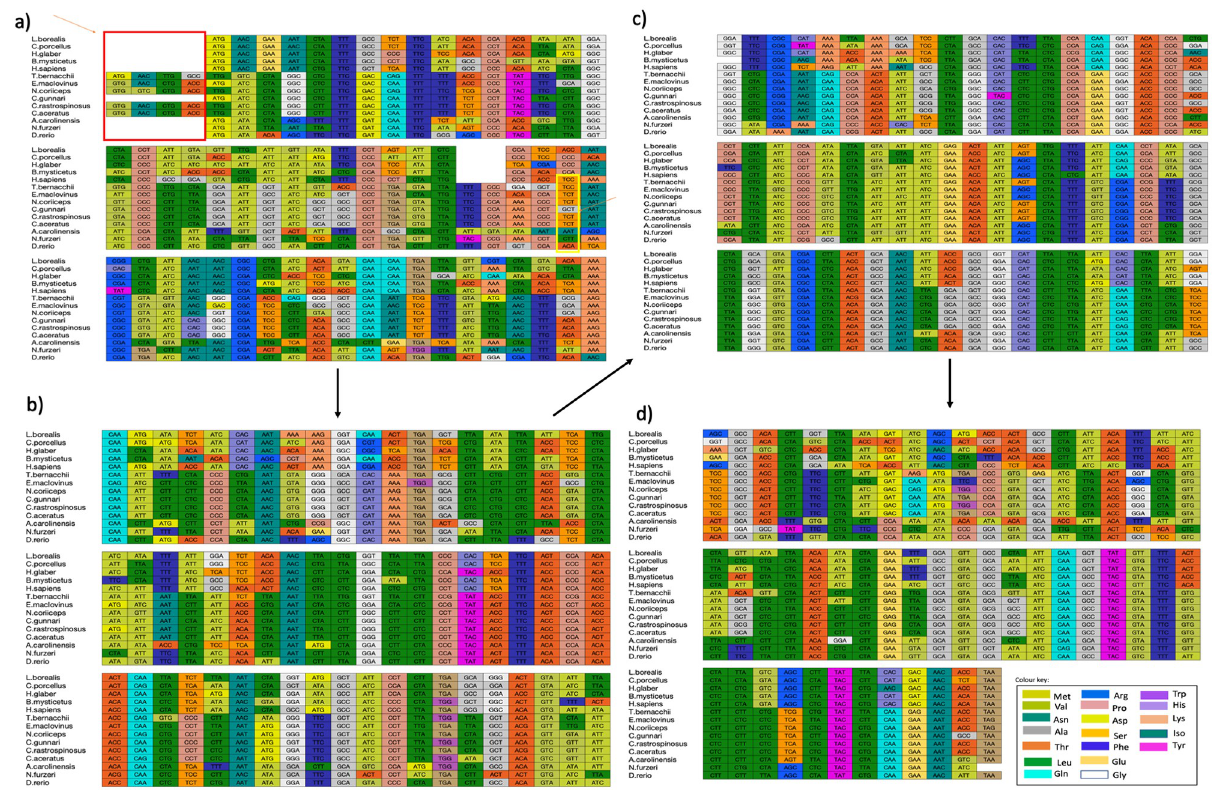
Fig 2. (a-d) Multiple sequence alignment for nucleotide sequences of ATP synthase subunit 6. Multiple codon alignment of nucleotide sequences of ATP synthase subunit 6 was created using the Clustal omega alignment of nucleotides for five Antarctic and one sub-Antarctic fish species and eight vertebrate outgroups and visualised) using MATLAB. The colour of the codon boxes corresponds to the respective amino acid (See colour key).